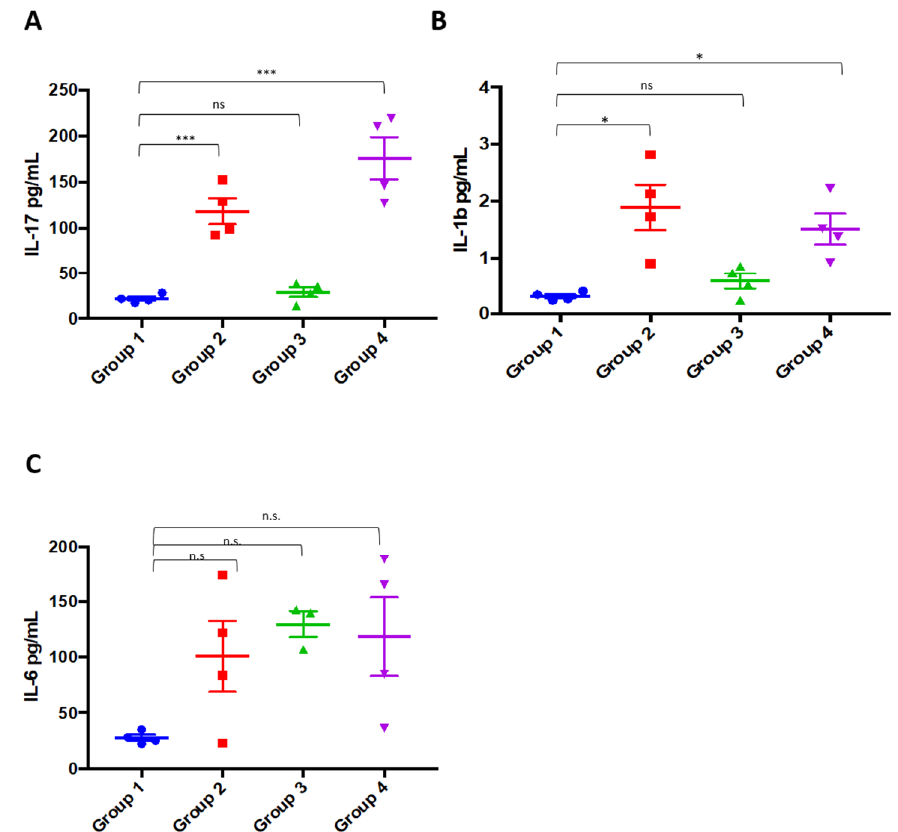
Figure 4. PPP (propolis, pomegranate, and grape pomace) mixture inhibits the expression of IL-17 and IL-1b. IL-17 ( A ), IL-1b ( B ), and IL-6 ( C ) levels measured in each sample of the indicated experimental groups. Symbols refer to the cytokine levels measured in each sample; horizontal lines indicate mean values ± SEM for each group. * p < 0.05; *** p < 0.001; ns / n.s. = not significant, as calculated using one-way